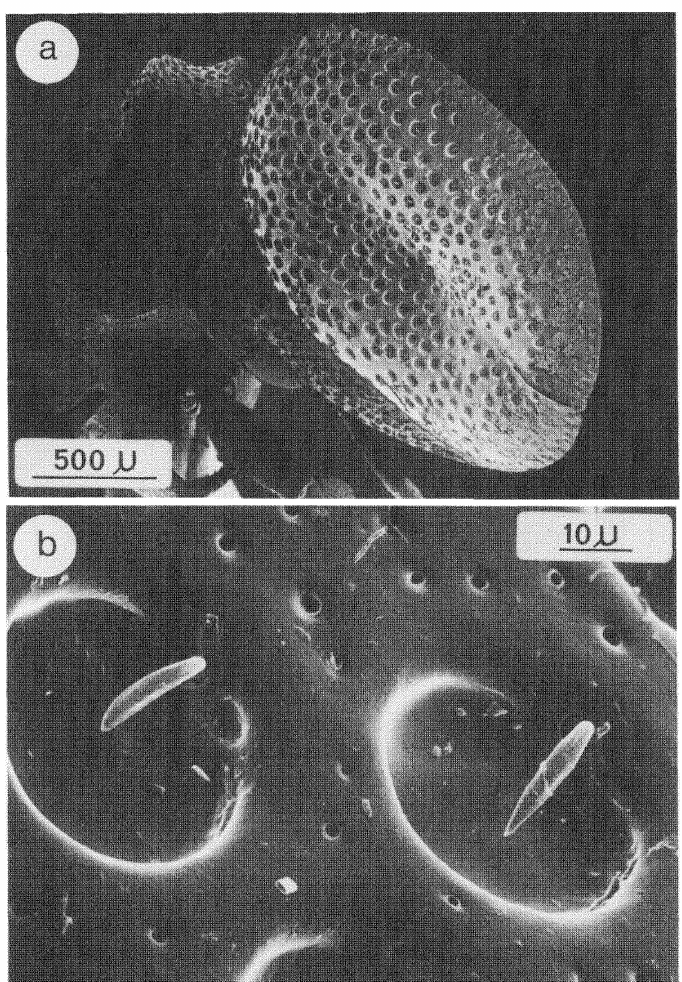
Fig. I. Zacryptocerus varians (Upper Matecumbe Key, FL). Soldier. a. SEM view of relatively clean cephalic shield, b. Surface of clean shield. Note the numerous pores (glandular